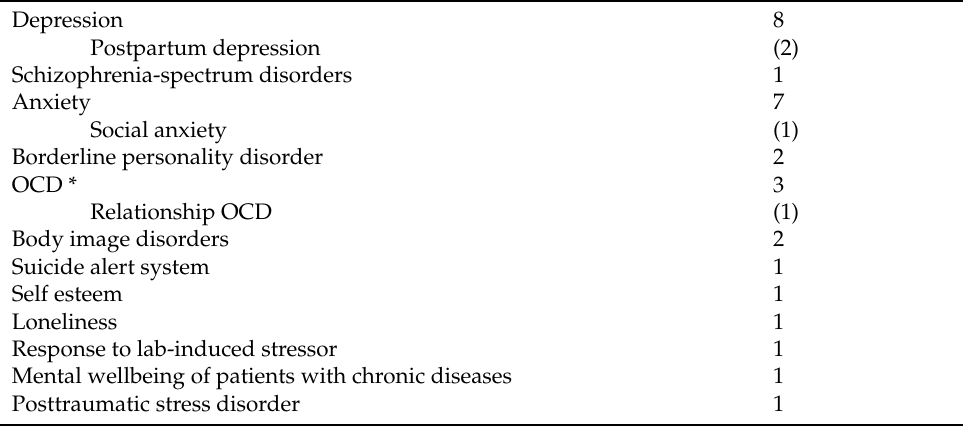
Table 3. Disease or treatment areas addressed in each